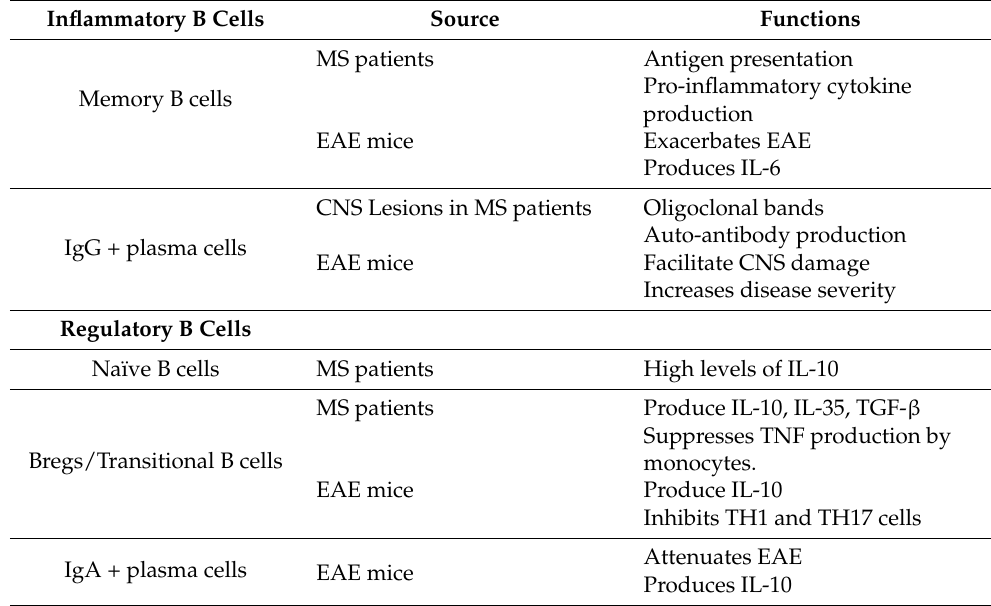
Table 1. Inflammatory and regulatory B cell subsets in